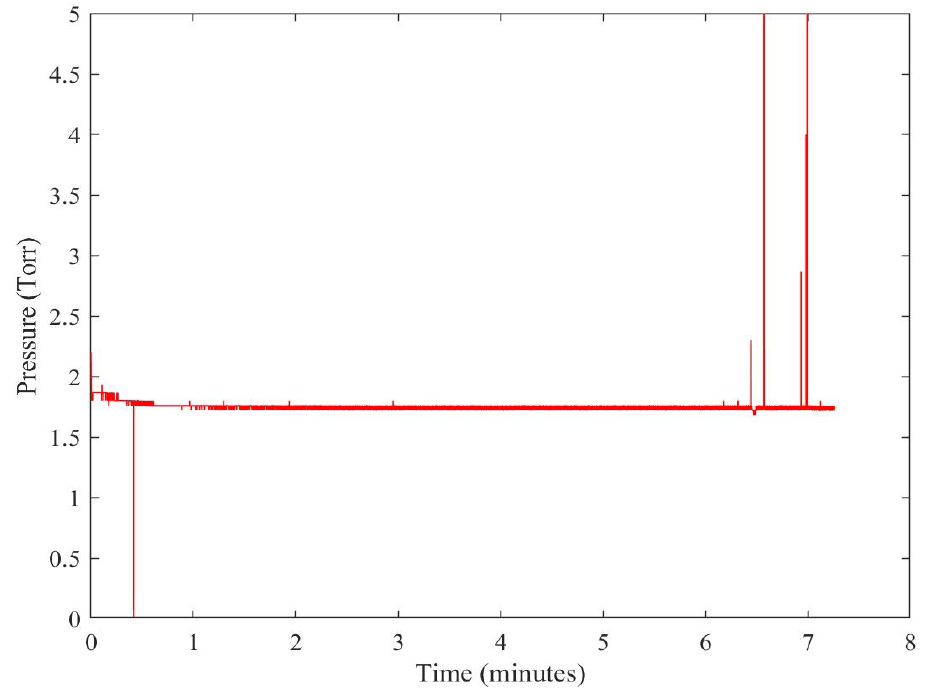
Figure 6. Pressure versus time graph showing last minute with anomalies for 0% overlap parts printed nine at once after heat treatment.